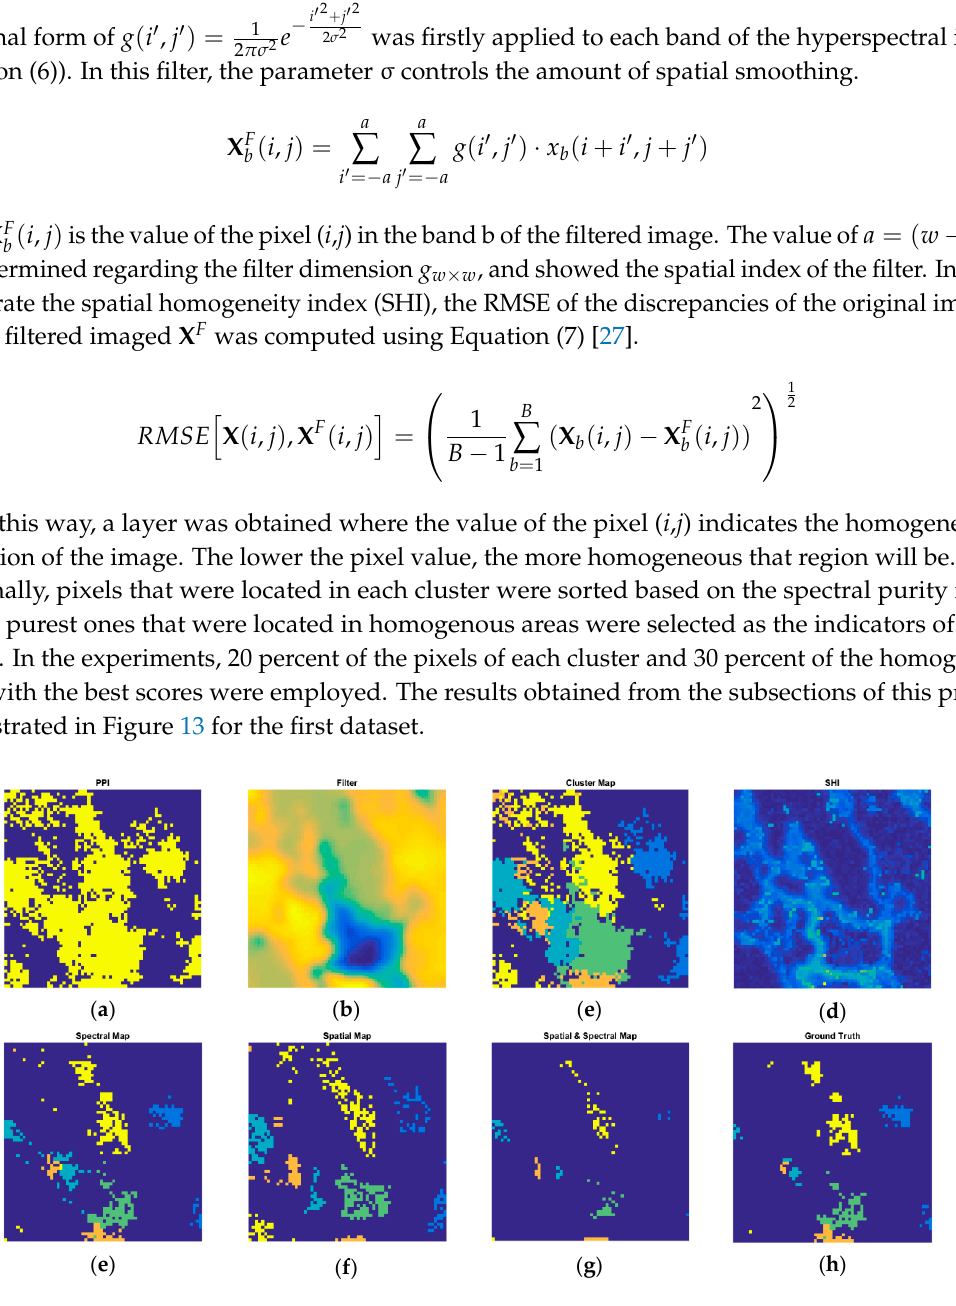
Figure 13. The results obtained from the subsections of the process of extraction of the spectral library of each class from the image: ( a ) Output of the pixel purity index (PPI) for greater than zero pixels; ( b ) The result of band filtering; ( c ) The clustering of PPI’s output; ( d ) Map of the homogeneity scores of pixels; ( e ) 20 percent of pixels of each cluster with the maximum value of PPI; ( f ) 30 percent of pixels of each cluster with the best homogeneity; ( g ) Fusion of maps ( e , f ) to extract the final pure pixels; ( h ) Ground truth map of the image’s endmembers.